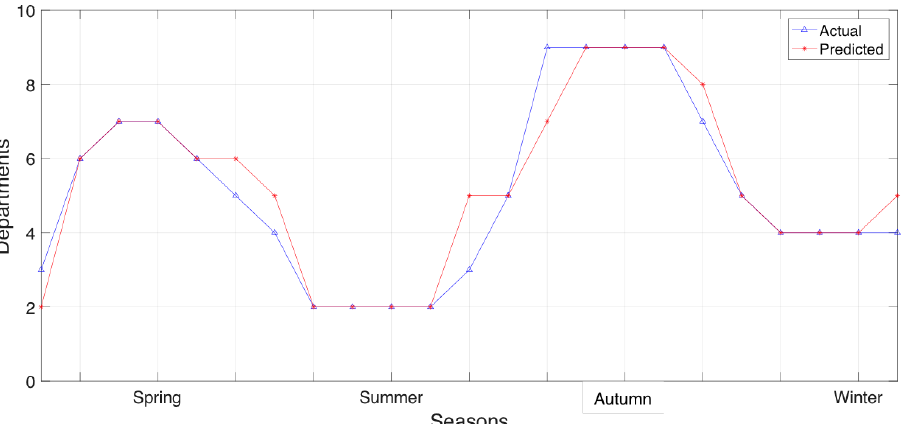
Figure 9. Actual and predicted distribution of municipality section Cholargos department resource allocation per season.